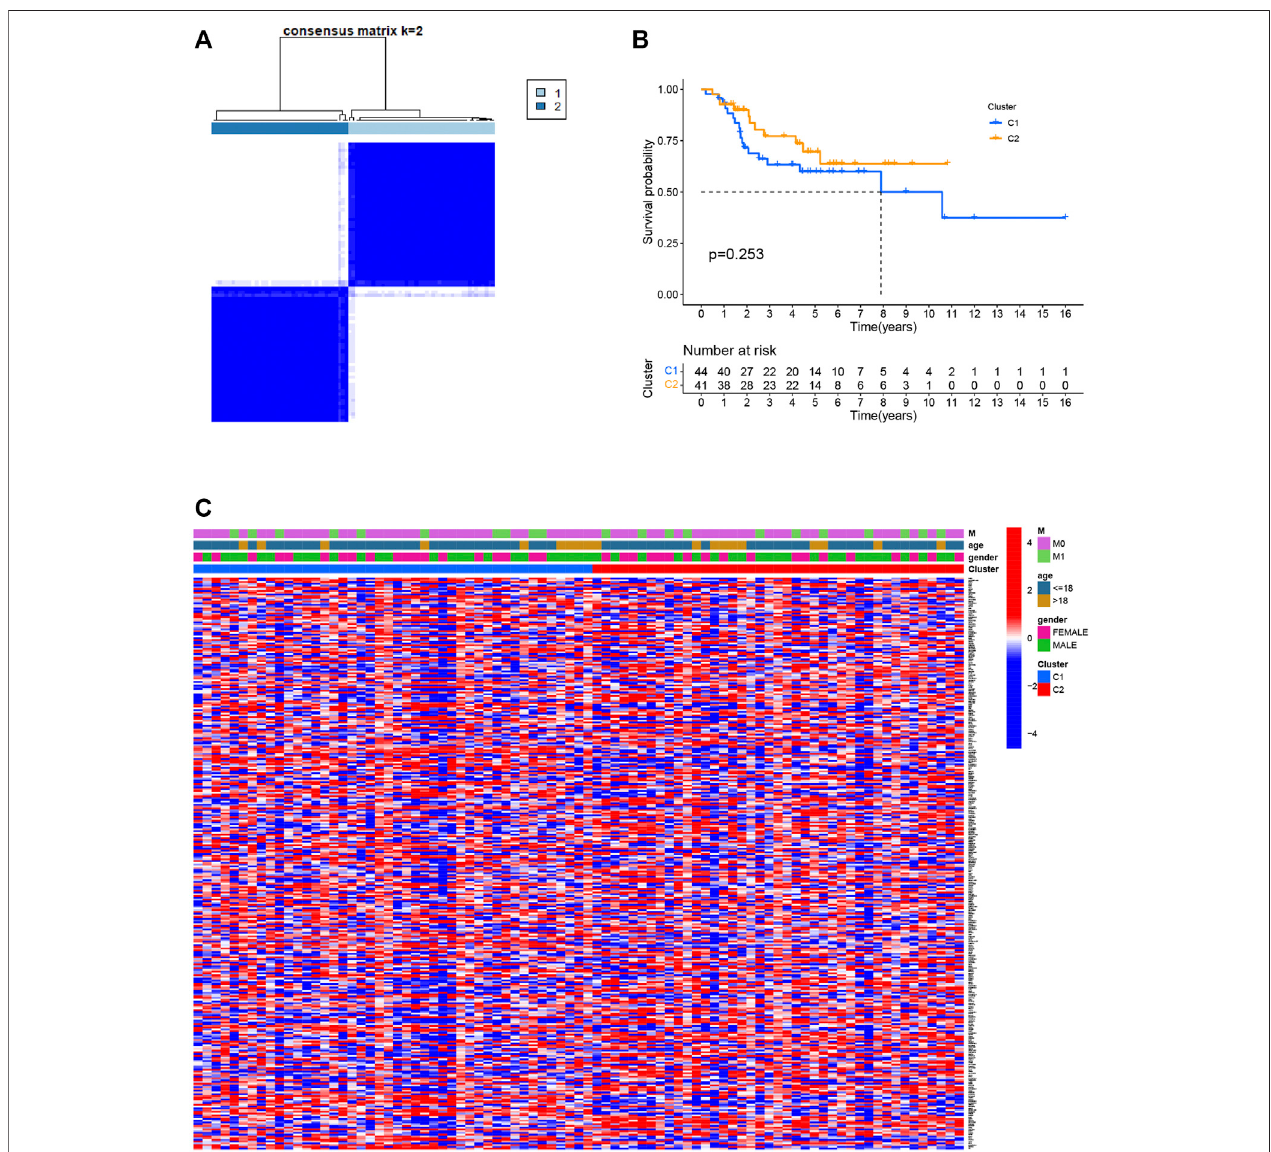
FIGURE 3 | Classi fi cation of osteosarcoma patients based on pyroptosis-related regulators. (A) Consensus clustering of osteosarcoma patients for k (cid:1) 2. (B) The prognostic analysis between the two pyroptosis-related clusters. (C) Heatmap of the differentially expressed genes and clinical characteristics between the two pyroptosis-related